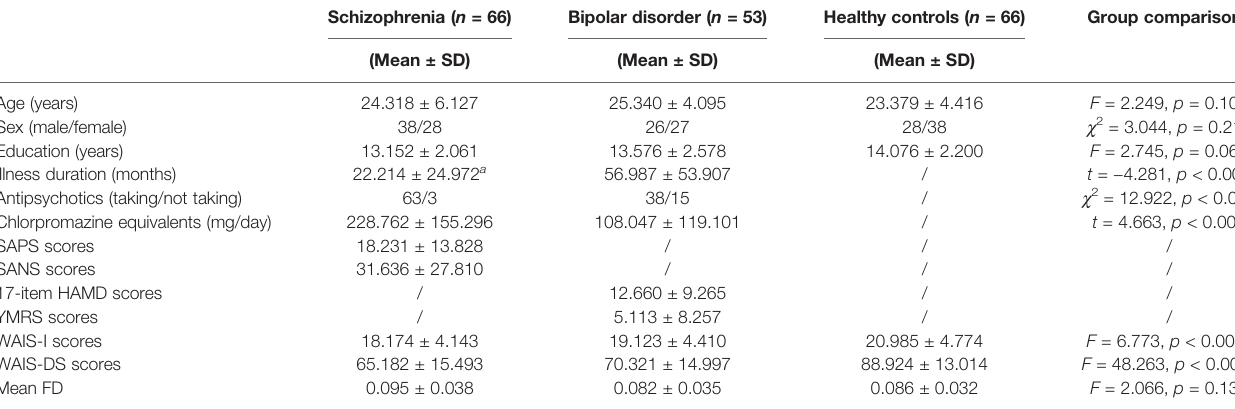
TABLE 1 | Demographic, clinical, and head motion characteristics of the three